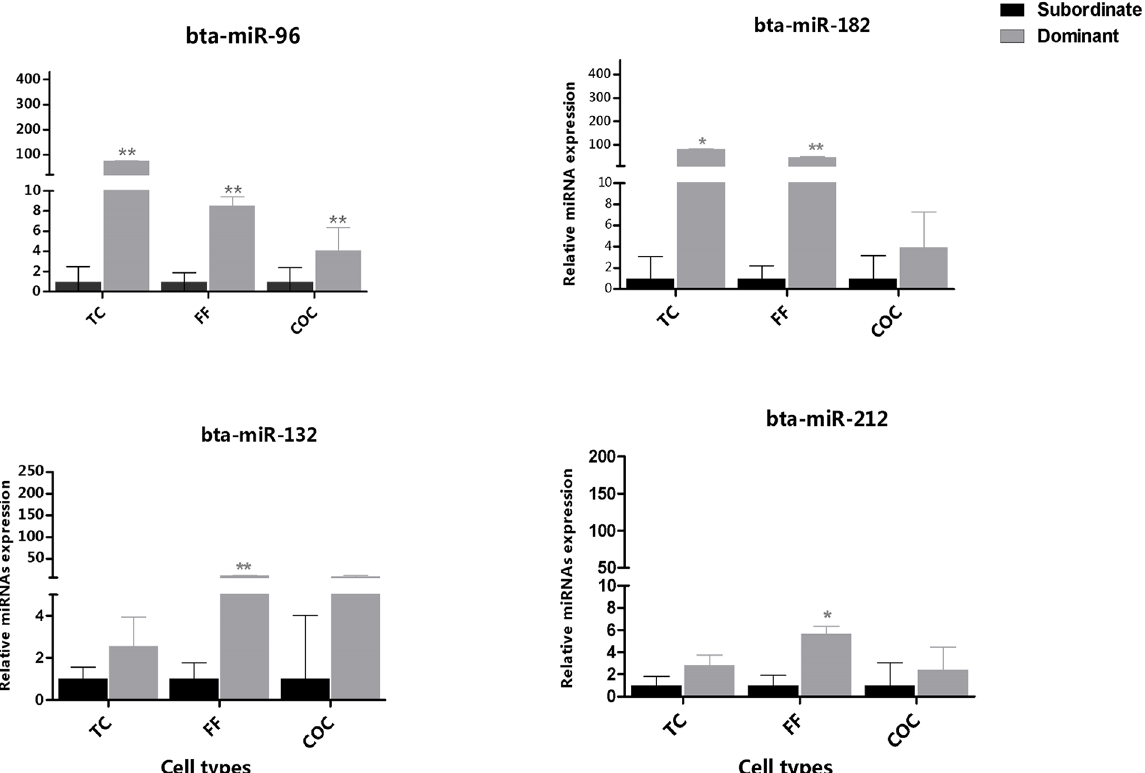
Fig 6. Expression pattern of members of the miR-183 cluster (bta-miR-182 and bta-miR-96) and miR-132 cluster (bta-miR-132 and bta-miR-212) in companion follicular cells of both preovulatory dominant and subordinate follicles using qPCR. The mean expression value of target miRNA was normalized against the expression of endogenous control U6 snRNA and 5s rRNAs. Relative expression values were calculated using ΔΔ CT method. Error bars represent SD of ΔΔ CT values. Statistical significance of each miRNA are represented by asterisks; * , p < 0.05, ** , p < 0.01 and *** , p < 0.001. Legend: TC = Theca cells COC = cumulus-oocyte-complex FF = follicular fluid.